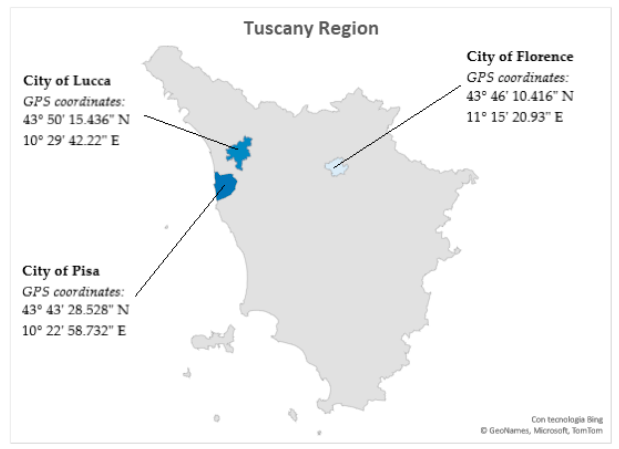
Figure 1. Map of the cities included in the study.